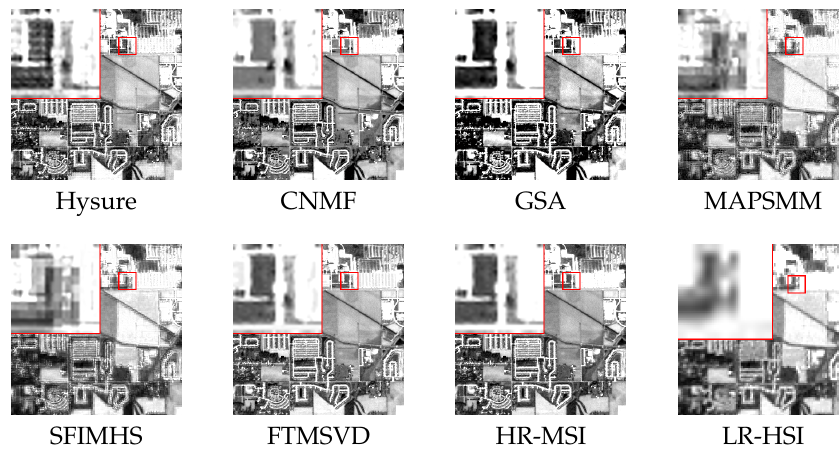
Figure 8. The fusion results of the blind methods on the real data set (the first